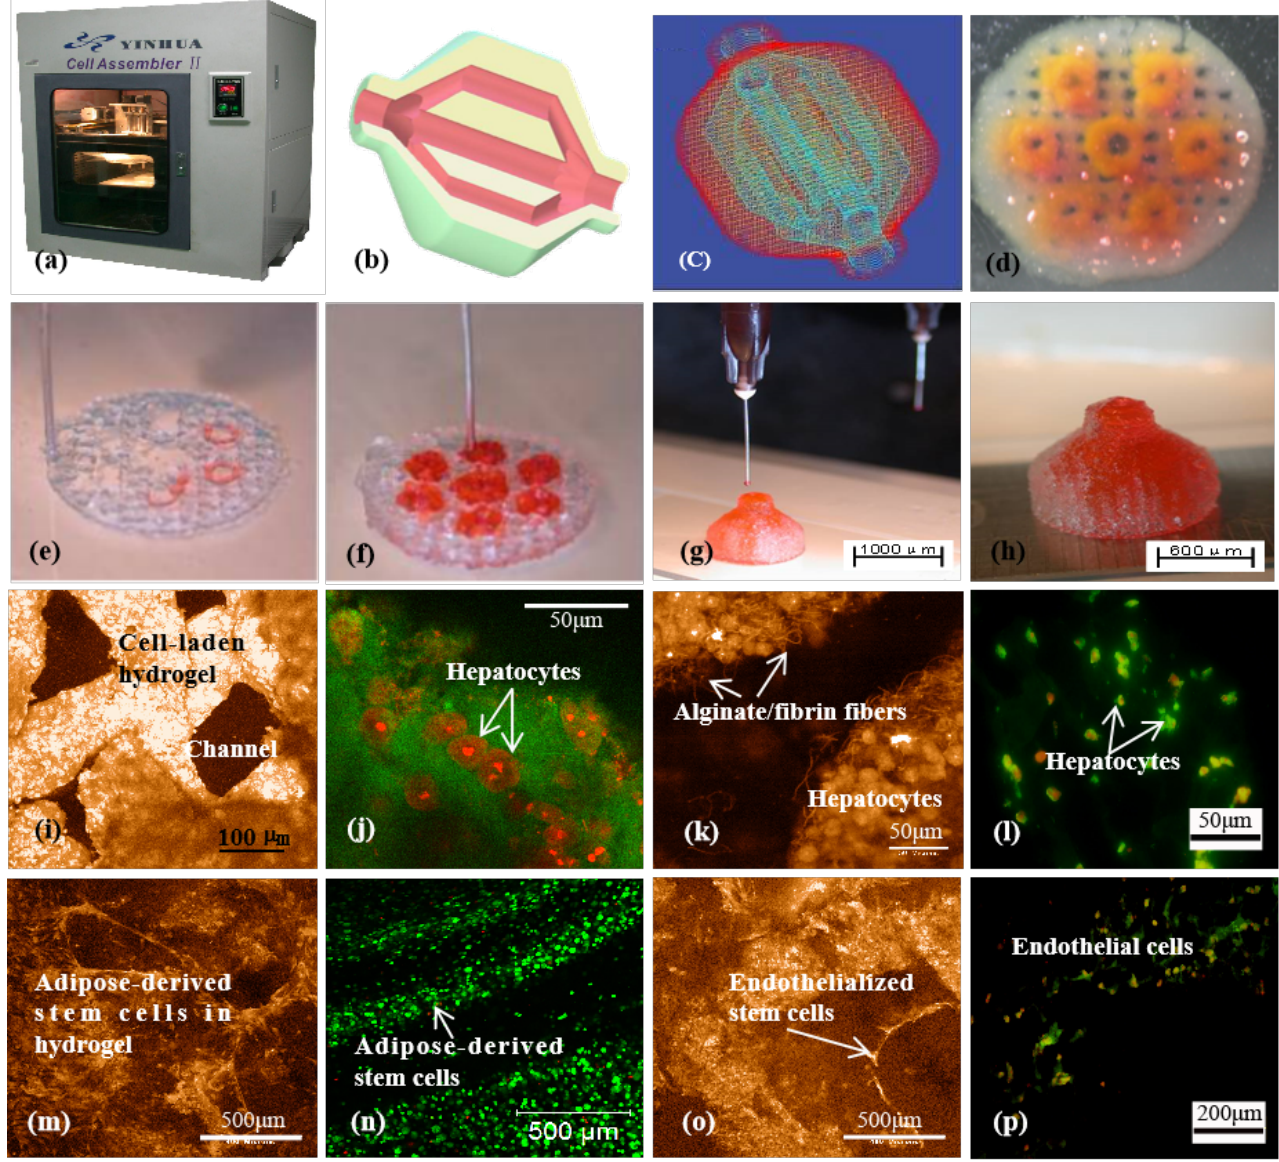
Figure 4. A large scaled-up 3D printed bioartificial organ with vascularized liver tissue constructed through the double-nozzle 3D bioprinter created at Tsinghua Unversity in Prof. Wang’s laboratory: ( a ) the double-nozzle 3D bioprinter; ( b ) a computer-aided design (CAD) model containing a branched vascular network; ( c ) a CAD model containing the branched vascular network; ( d ) a few layers of the 3D bioprinted construct containing both adipose-derived stem cells (ASCs) encapsu- lated in a gelatin/alginate/fibrin hydrogel and hepatocytes encapsulated in a gela- tin/alginate/chitosan hydrogel; ( e – h ) 3D printing process of a semi-elliptical construct containing both ASCs and hepatocytes encapsulated in different hydrogels; ( i – l ) hepatocytes encapsulated in the gelatin-based hydrogels after 3D bioprinting and different periods of in vitro cultures; ( m – p ) ASCs encapsulated in gelatin-based hydrogels after 3D bioprinting and different periods of in vitro culture as well as growth factor induction [99].